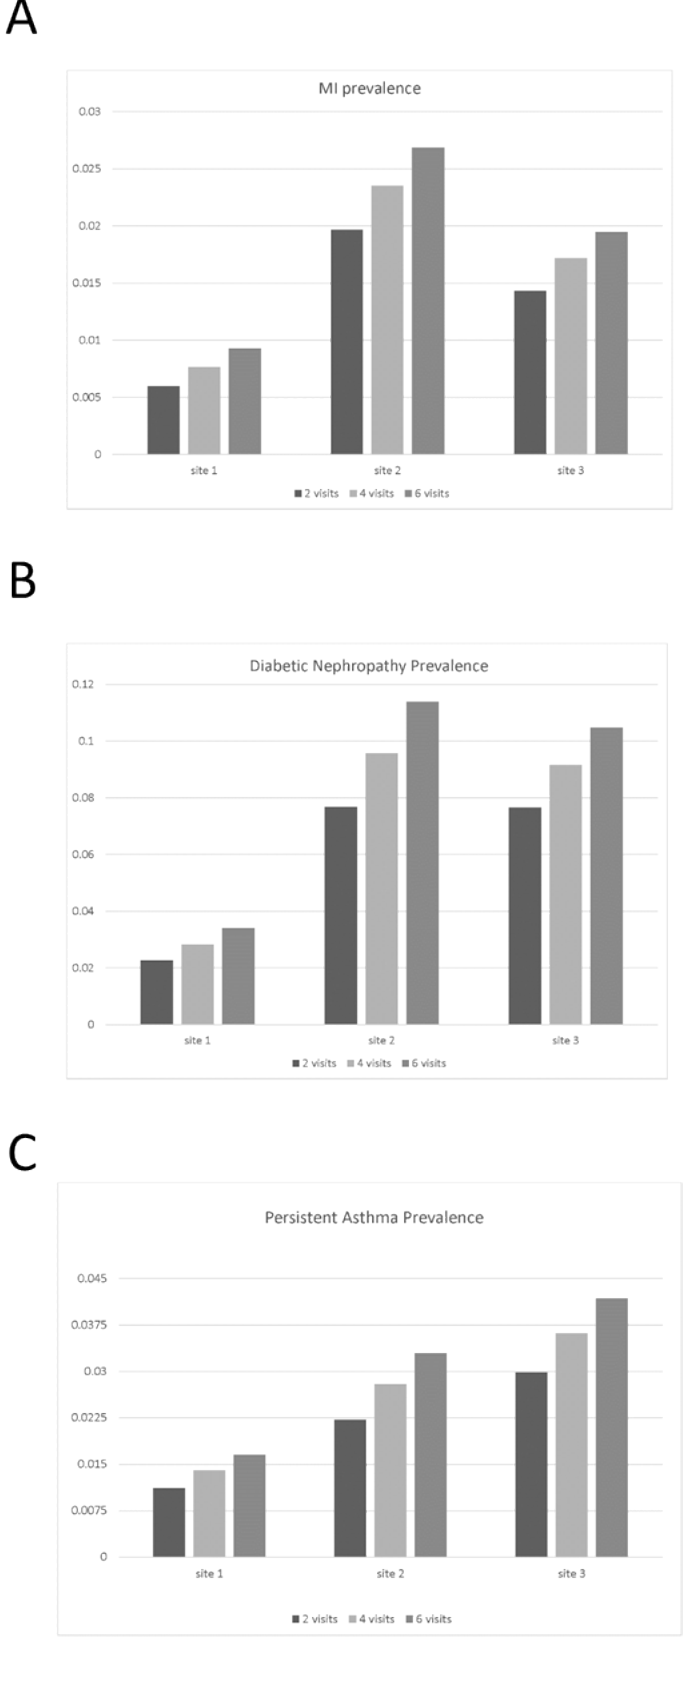
Figure 2: Variation in basic descriptive epidemiology metrics (example: period prevalence) with increase in minimum number of health care visits required to be included in the study sample. Estimates of period prevalence during 2016 for (a) myocardial infarction (b) diabetic nephropathy and (c) persistent asthma, for different minimum numbers of required visits during